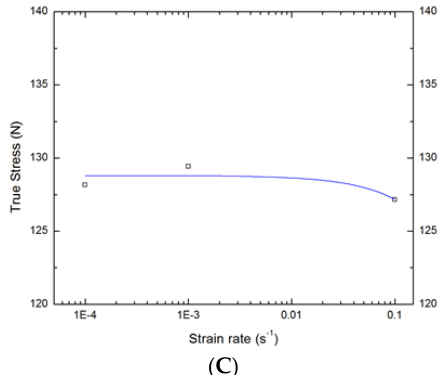
Figure 8. Parametric analysis of true stress of AZ31 with ( a ) P–B ratio, ( b ) Temperature and ( c ) Strain rate. Square markers ( (cid:3) ) in these plots refer to the data samples of true stress and the corresponding inputs.